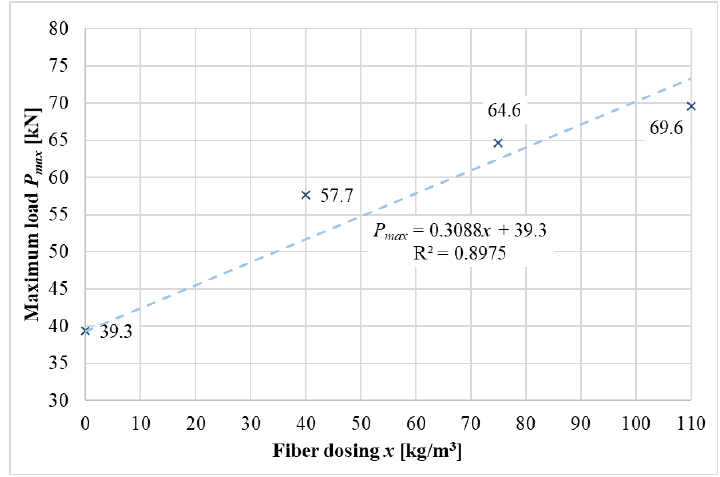
Figure 19. Regression analysis to determine the functional dependence of the maximum load P max on fiber dosage x .